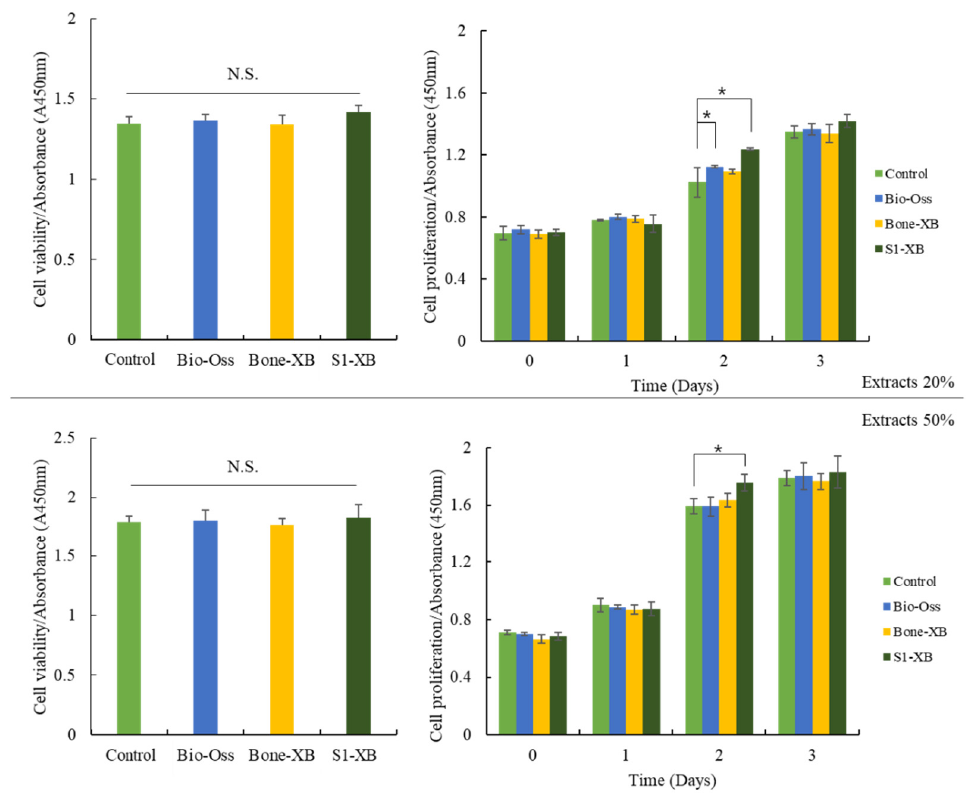
Figure 4. Cell viability and proliferation of human mesenchymal stem cells (hMSCs) exposed to the different extracts. The letter “*” indicates significant differences ( p < 0.05); N.S.—No